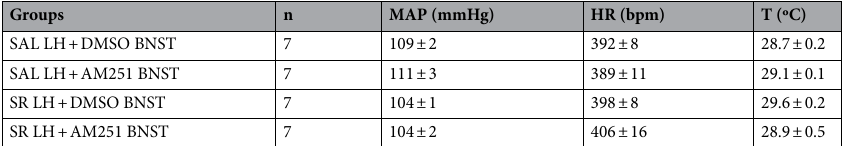
Table 1. Basal parameters of mean arterial pressure (MAP), heart rate (HR) and tail skin temperature (T) after pharmacological treatment of the BNST with the selective CB 1 receptor antagonist AM251 (or vehicle) and/or the LH with the selective GABA A receptor antagonist SR95531 (or vehicle). Values are mean ± SEM, one-way ANOVA. DMSO saline containing 30% of DMSO, SAL saline, SR SR95531.